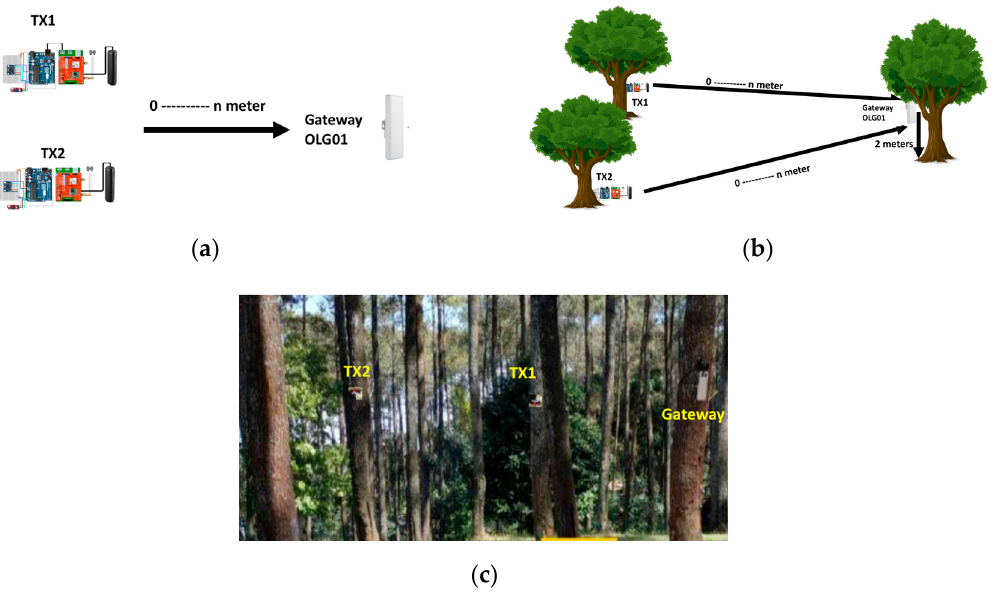
Figure 10. Scenario testing of ( a ) line of sight (LoS) at soccer field; ( b ) non-line of sight (N-LoS) at Telkom University area; ( c ) N-LoS in the forest.